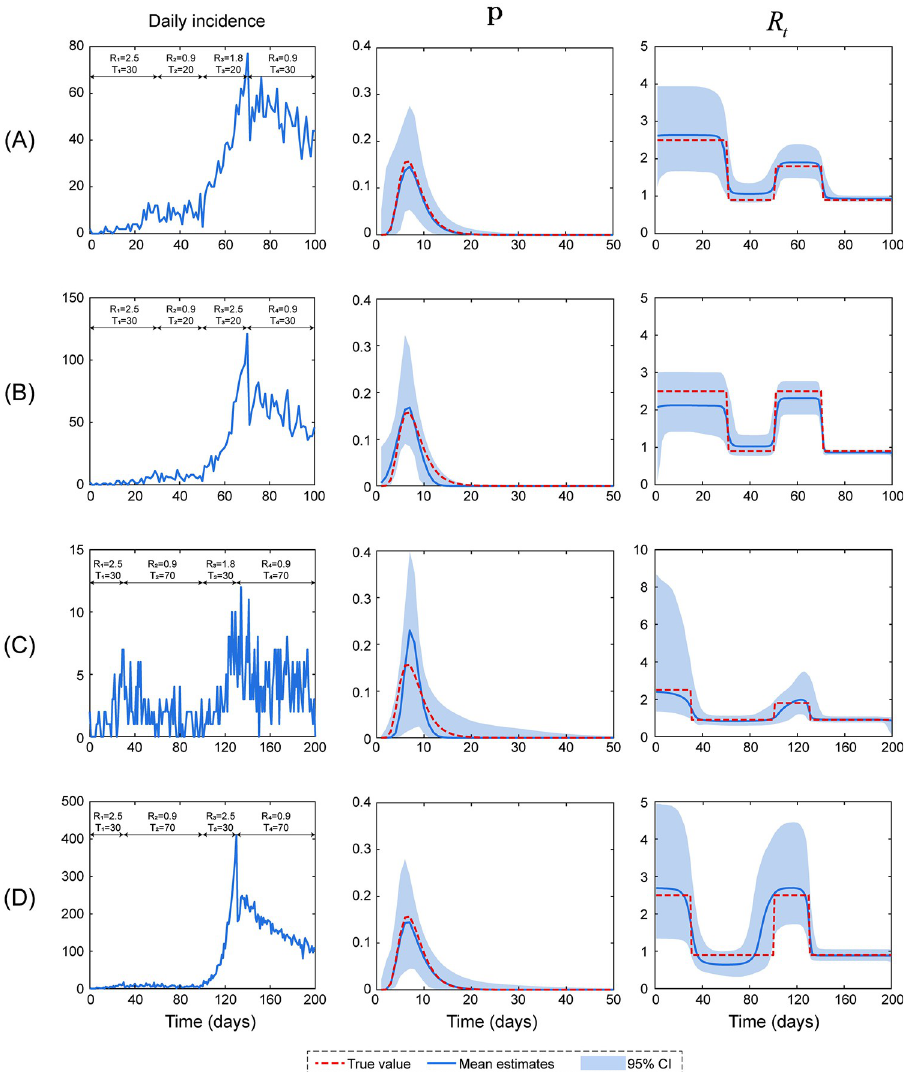
Fig 5. Four examples in which an outbreak was first controlled, then rebounded and was finally controlled again were used for the simulation study in scenario two. Simulations were performed based on the assumptions that the number of initial cases was 2 and the serial interval exhibited a lognormal distribution with a mean and variance of 8 and 9, respectively. Each epidemic was split into four stages, and R 1 − R 4 and T 1 − T 4 are key parameters that determine the epidemic severity and end time, respectively. The left, middle and right panels present the daily incidence and estimates of the serial interval and instantaneous reproductive number, respectively. The blue lines show the estimates, and the light blue area denotes their 95% credible intervals. The red dashed lines represent the ground